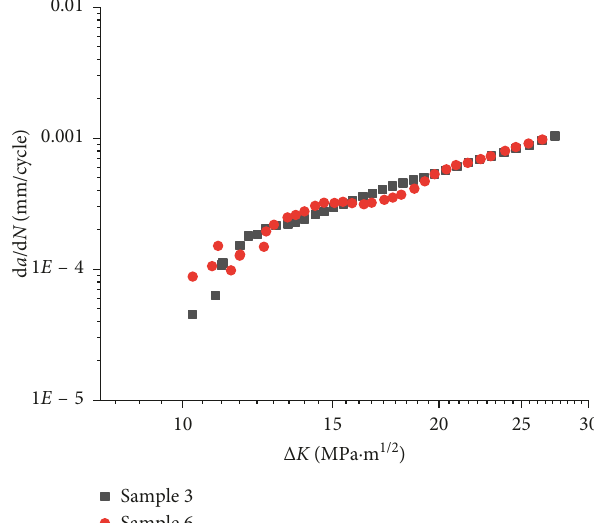
Figure 13: Crack growth rates for samples 3 and 6.